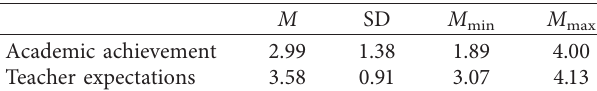
Table 2: Descriptive statistics for academic achievement and teacher expectations (range 1–5; N �